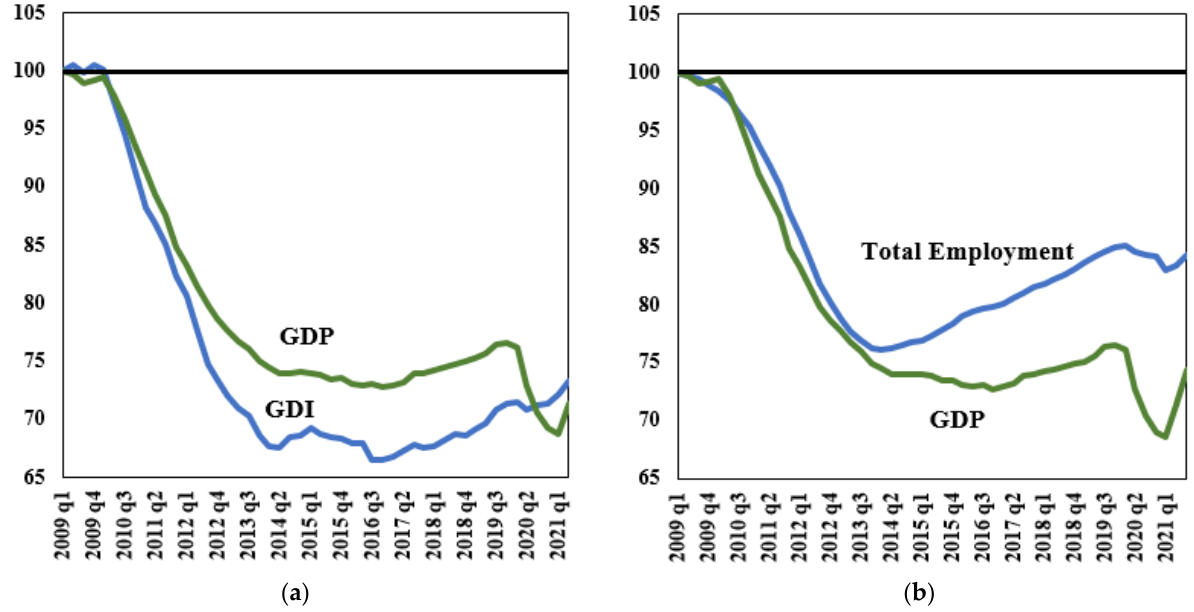
Figure 2. Gross Domestic Product (GDP) and Gross Disposable Income (GDI) ( a ) and GDP and Total Employment ( b ) compared to 2009q1 (100), 2009q1–2021q3, Greece. Source: ELSTAT and authors’ calculations.